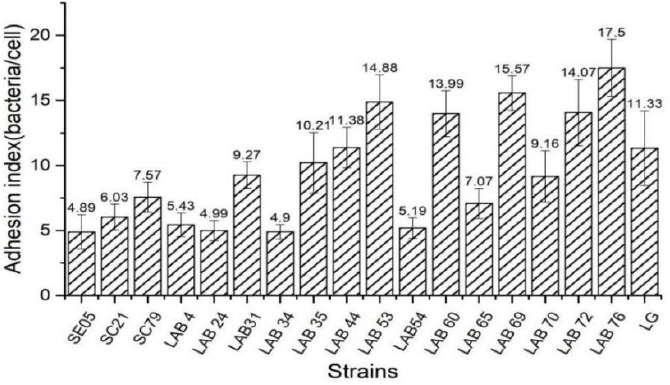
Figure 3. Adhesion index of different bacteria to CaCO-2 cells.